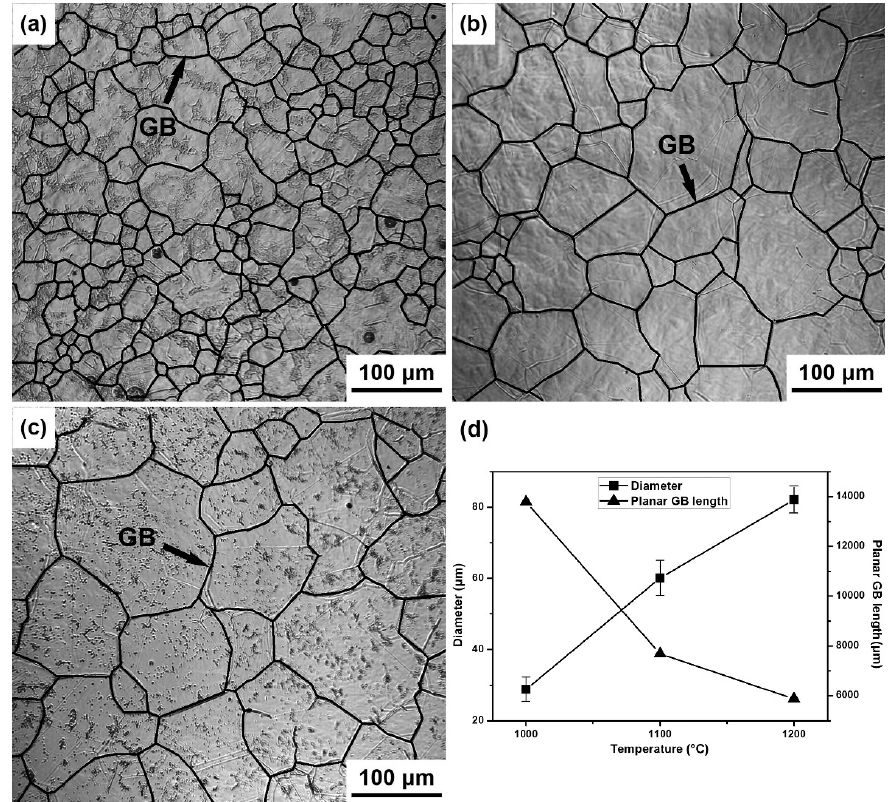
Figure 4. In situ observation of prior austenite grains at different austenitization temperatures on the LSCM: ( a ) 1000 °C; ( b ) 1100 °C; ( c ) 1200 °C; and ( d ) prior austenite grain size and planar grain the LSCM: ( a ) 1000 ˝ C; ( b ) 1100 ˝ C; ( c ) 1200 ˝ C; and ( d ) prior austenite grain size and planar grain boundary (GB) length. boundary (GB)